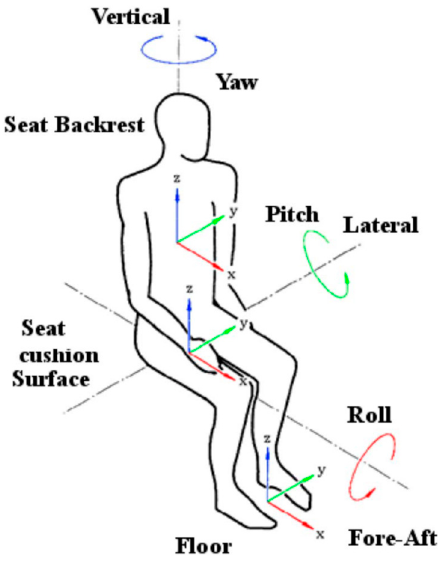
Figure 3. Vibration transmission directions through a vehicle seat occupant [33].